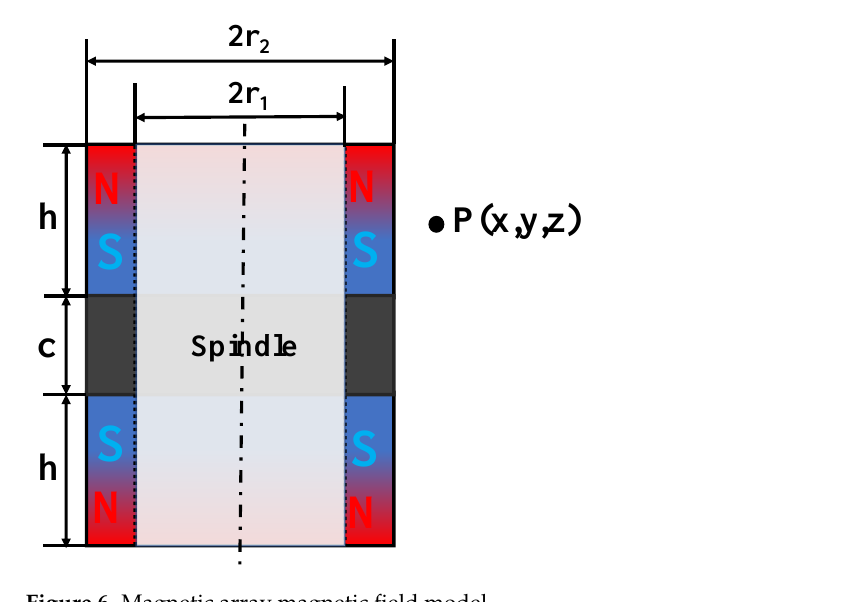
Two magnetic rings placed relative to each other are combined to form the spindle of the magnetic levitation actuator designed in this paper, as shown in Figure 6.